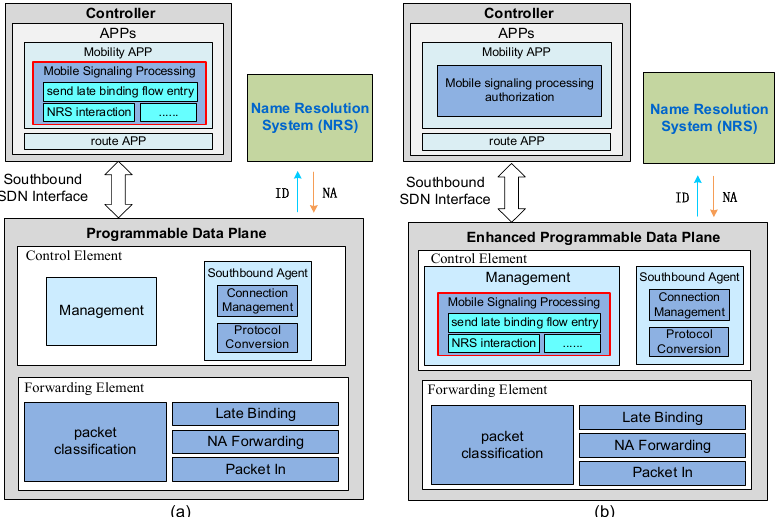
Figure 2. ( a ) Architecture of the traditional programmable data plane supporting ICN mobility. ( b ) Architecture of the enhanced programmable data plane supporting ICN